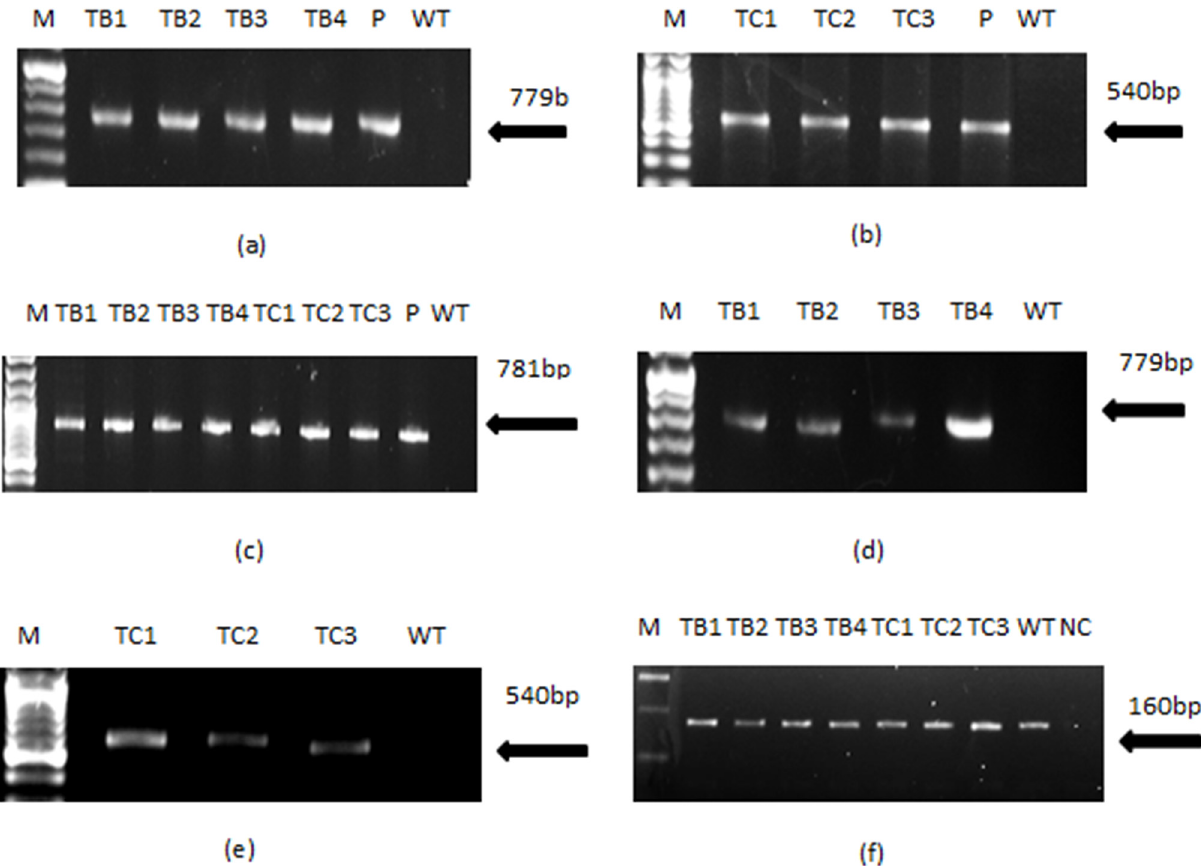
Fig 6. Gel pictures showing results of normal and semi quantitative reverse transcriptase PCR. PCR amplified products of rol B (a), rol C (b) and nptII (c) gene are shown in the figure. Semi quantitative RT-PCR showing the relative expression of rol B (d) and rol C gene (e). β -actin used as housekeeping gene (f). TB1-TB4 represents rol b transgenics whereas TC1-TC3 represent rol C transgenics. WT stands for wild type plant of A . carvifolia , lane “ P ” refers to the plasmid DNA and lane M corresponds to the marker DNA (Fermentas). NC = negative